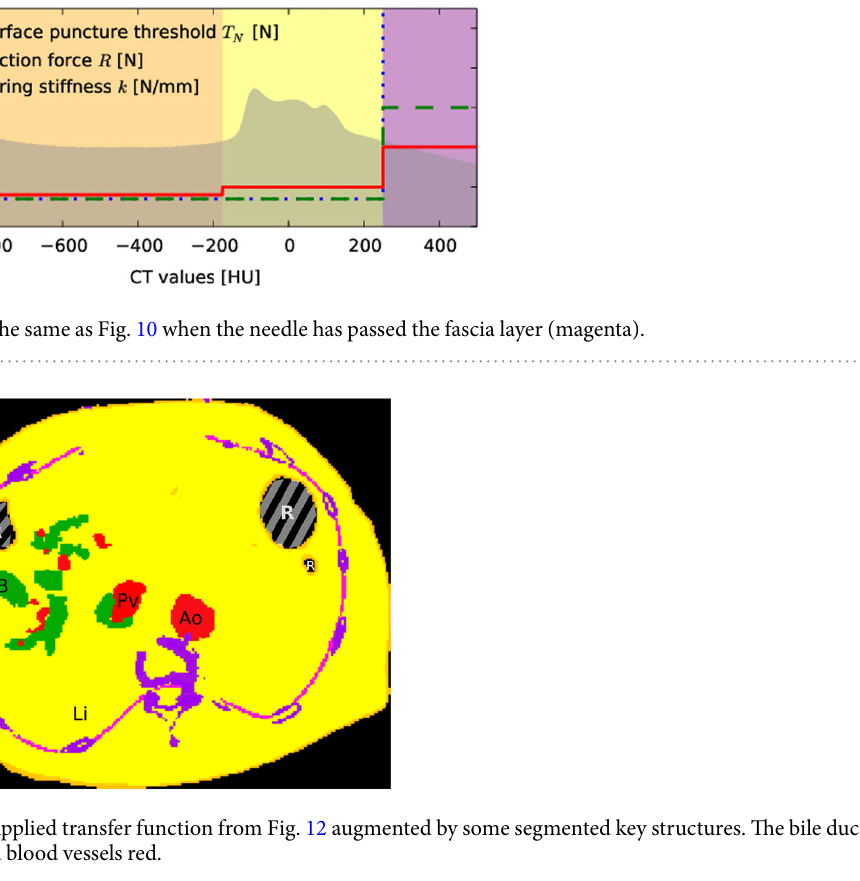
(inside fascia) 17, 18, 34 . 2